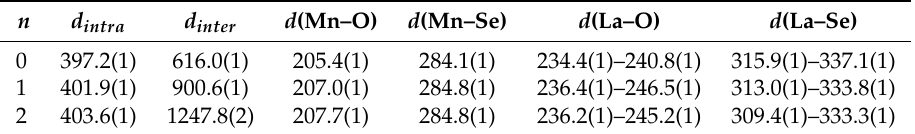
Figure 3. Coordination environments of the lanthanum ions in ( a ) mC -La 2 MnSe 2 O 2 ; ( b ) La 4 MnSe 3 O 4 and ( c ) La 6 MnSe 4 O 6 showing the connectivity between the distorted square and the mono-capped trigonal antiprisms. Table 2. Distances between the manganese atoms in ( d intra ) and between ( d inter ) the MnSe 4 O 2 - octahedra chains and selected bond lengths (/pm) of mC -La 2 MnSe 2 O 2 ( n = 0), La 4 MnSe 3 O 4 ( n = 1) and La 6 MnSe 4 O 6 ( n = 2).